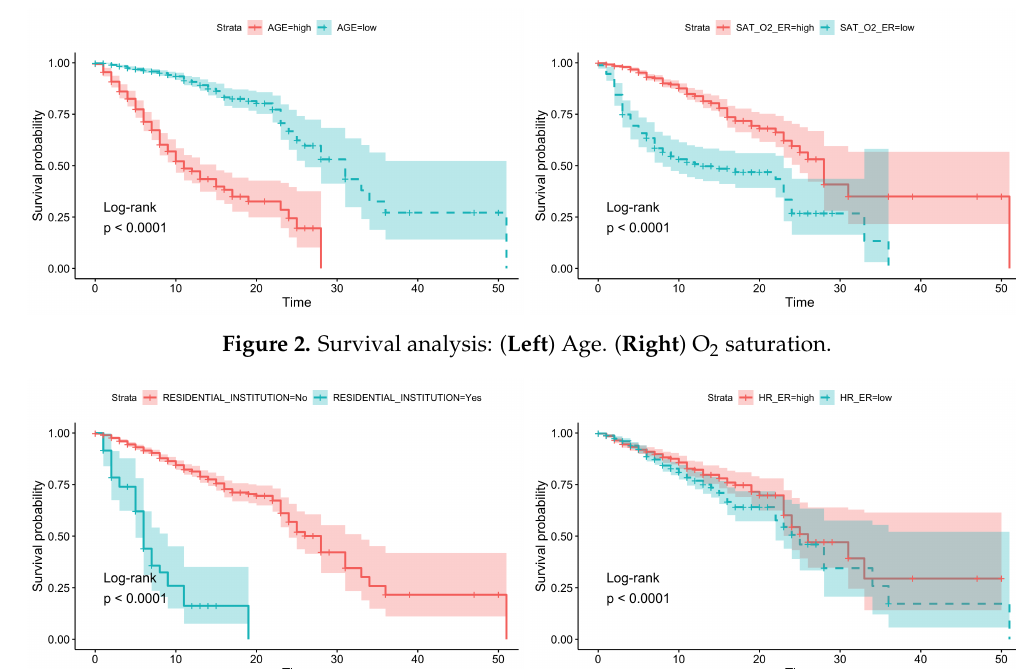
Figure 3. Survival analysis: ( Left ) Residential institution. ( Right ) heart